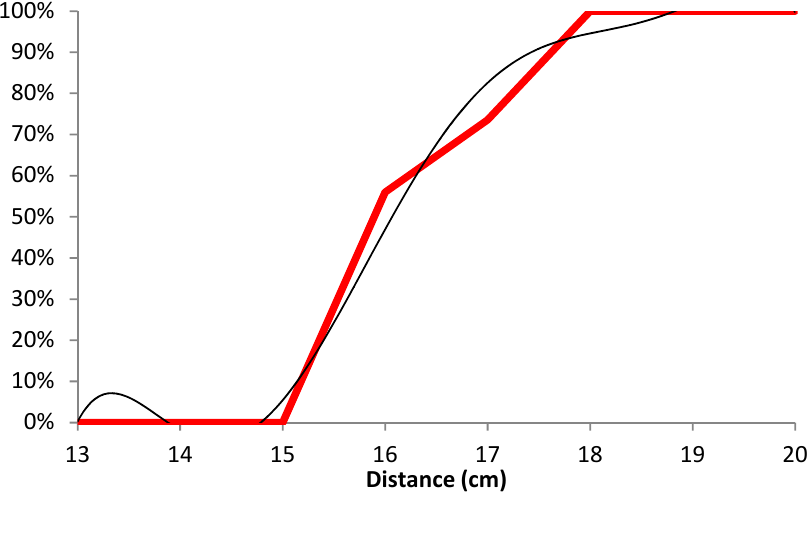
Figure 18. Average RTT for 2